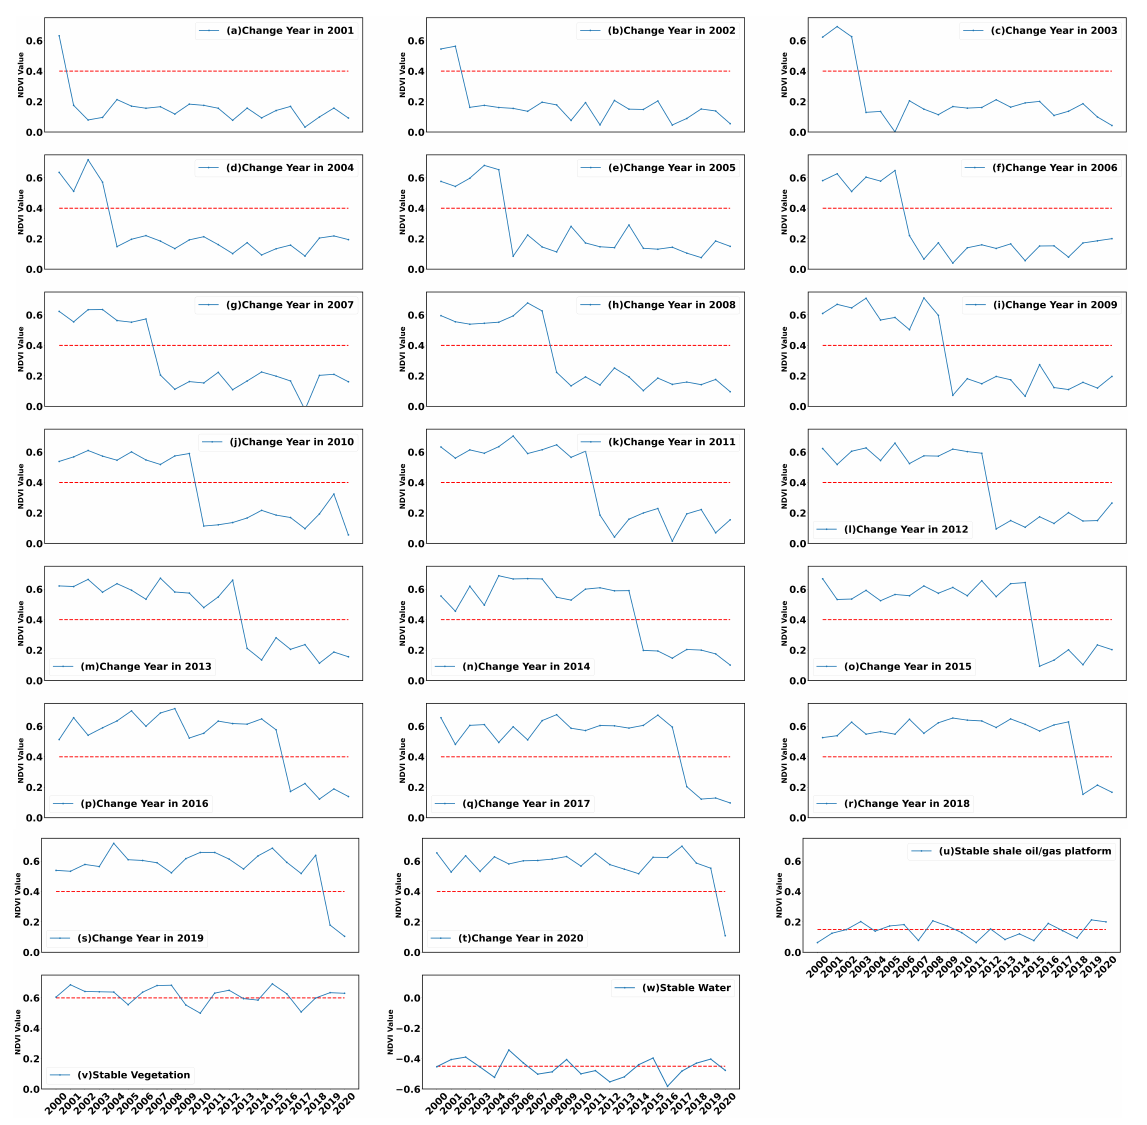
Figure 5. The 24 Gaussian random number templates, (a) to (t) The construction of shale oil/gas well platform in the year of curve mutation point, (u) stable shale oil/gas platform, (v) stable vegetation, and (w) stable Water.